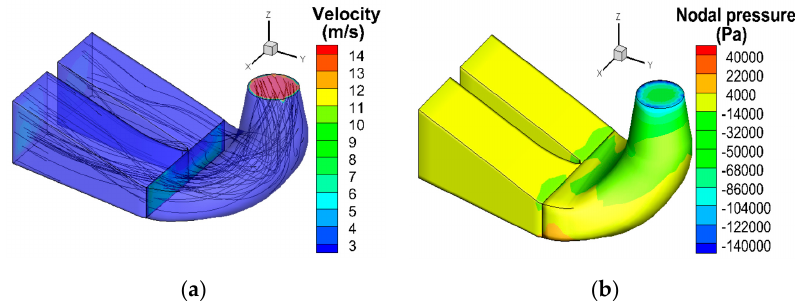
Figure 9. Distribution of velocity, streamline, and pressure in the draft tube. ( a ) Velocity and streamlines distribution, ( b ) pressure contour.